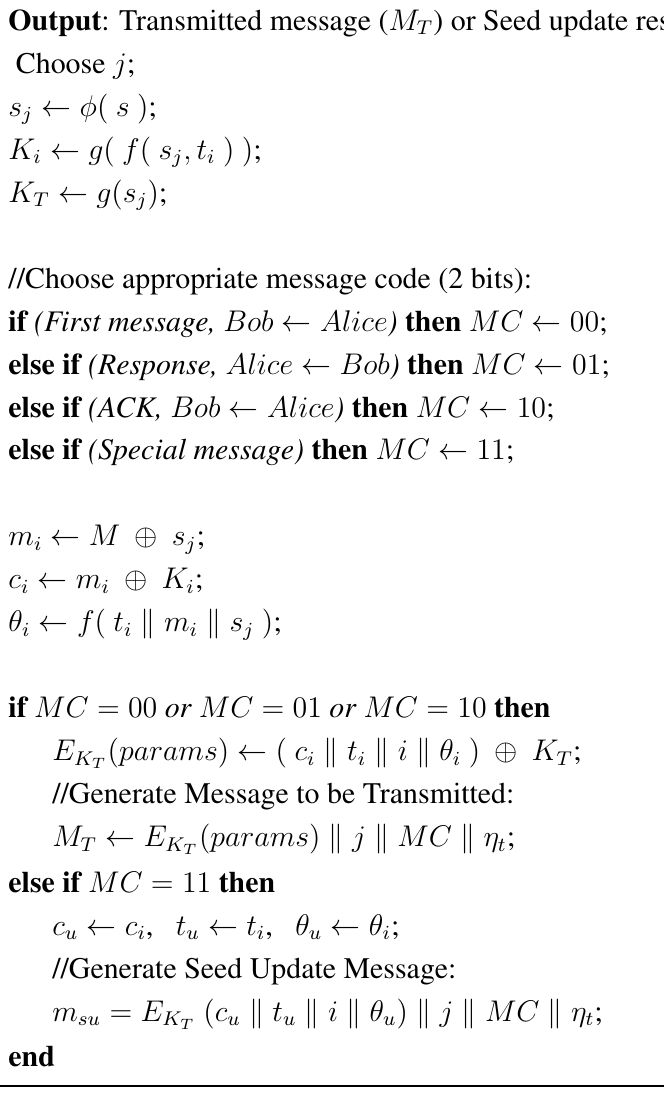
Algorithm 1: Key Generation and Encryption in the Butterfly Encryption